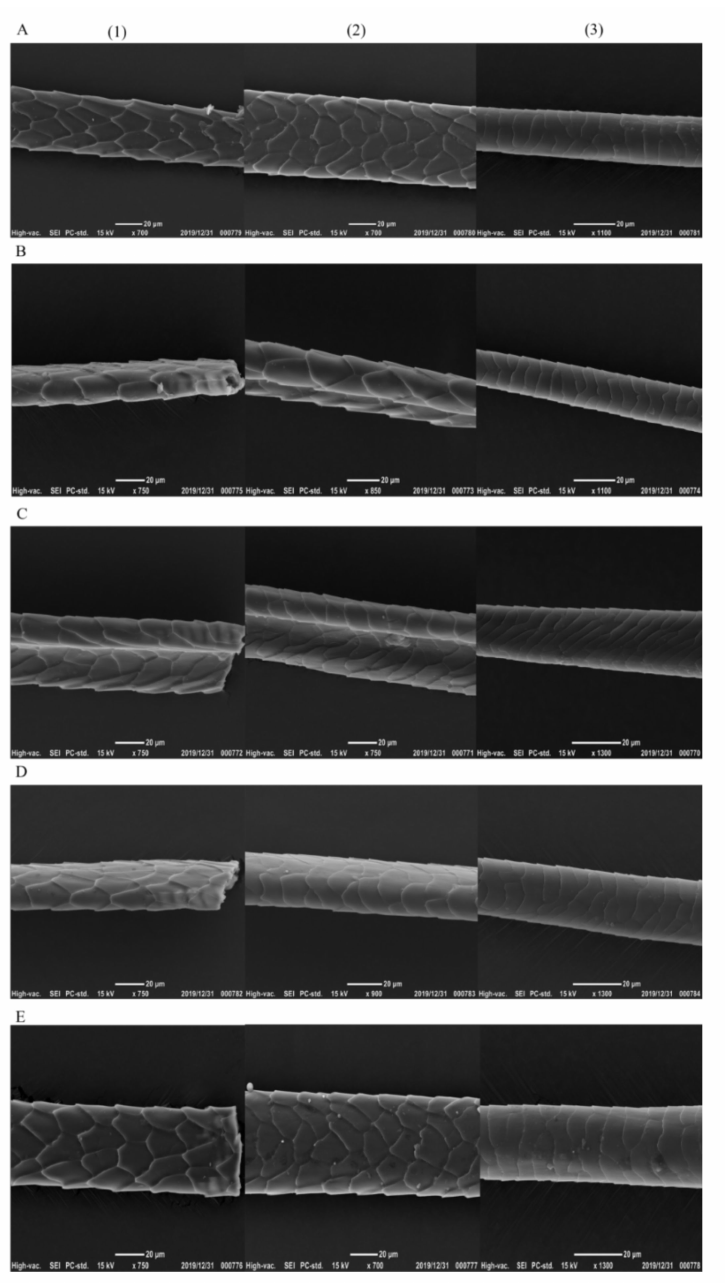
Figure 2. The hair characteristics of mice ( A – E refer to L-group, Y-group, LY-group, R-group and W-group, respectively, ( 1 )–( 3 ) refer to the head, middle and tail of the mice tail,